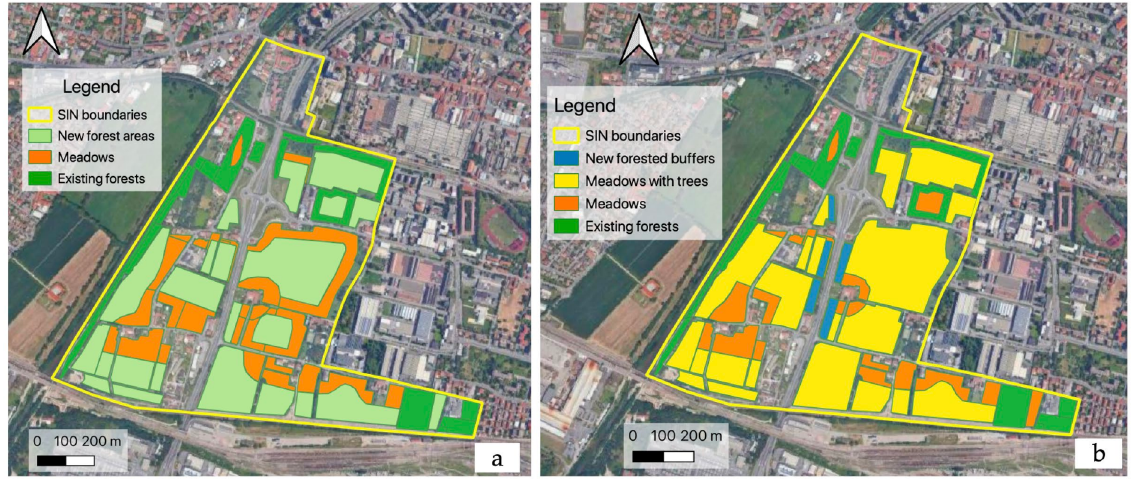
Figure 2. Intervention scenarios and their different land uses: ( a ) urban forest scenario and ( b ) meadows with sparse trees scenario.